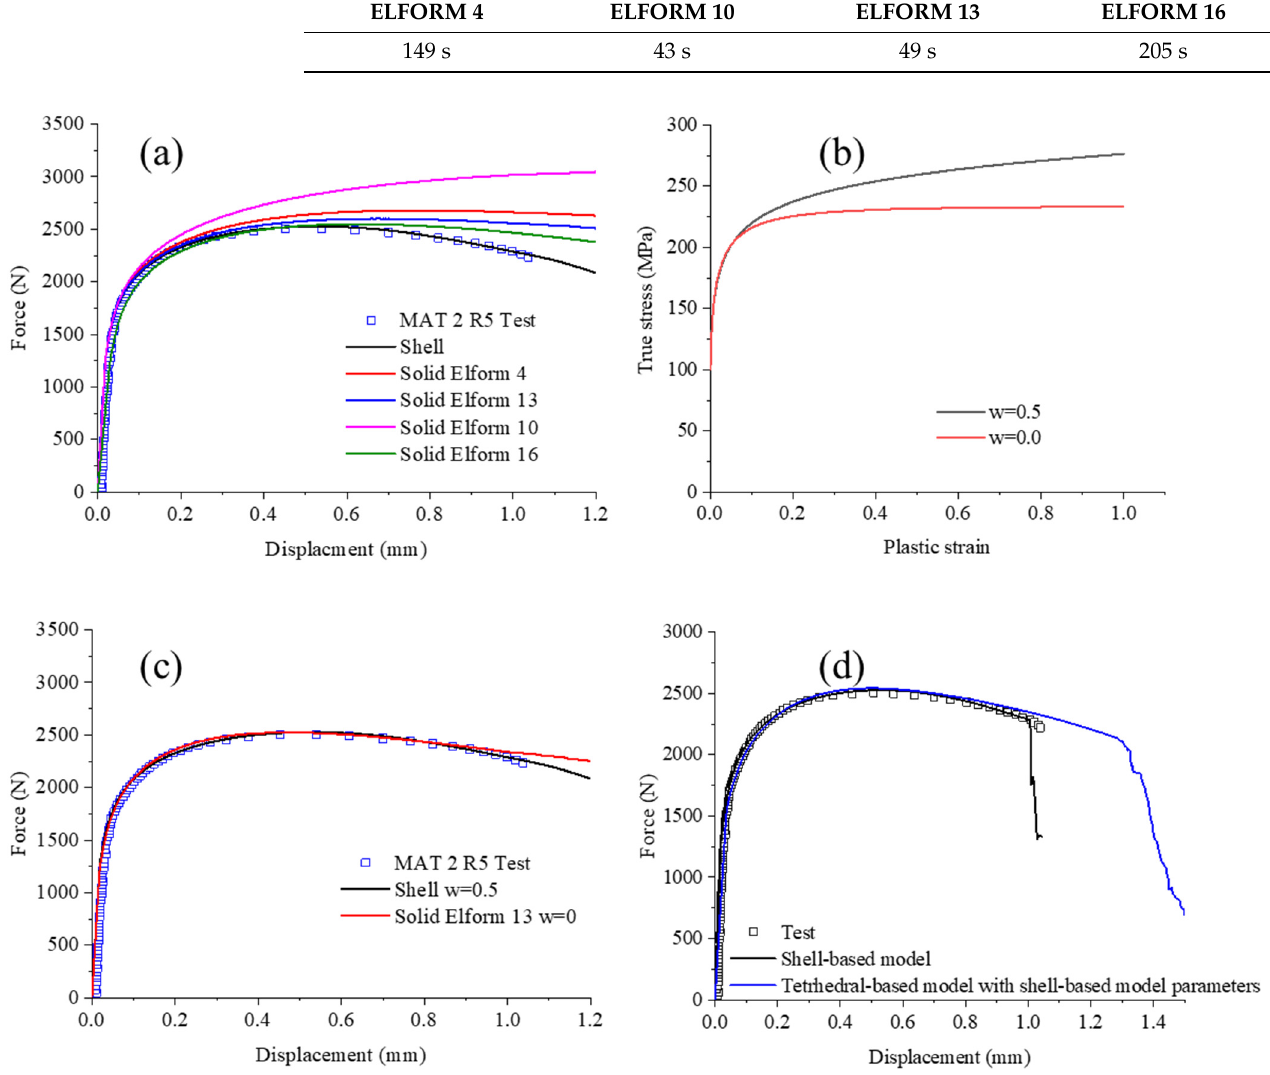
Figure 13. Tetrahedral elements comparisons for MAT 2: ( a ) element formulas, ( b ) extrapolating curves, ( c ) R5 model with a recalibrated weighting factor, and ( d ) R5 model with the shell-based GISSMO.